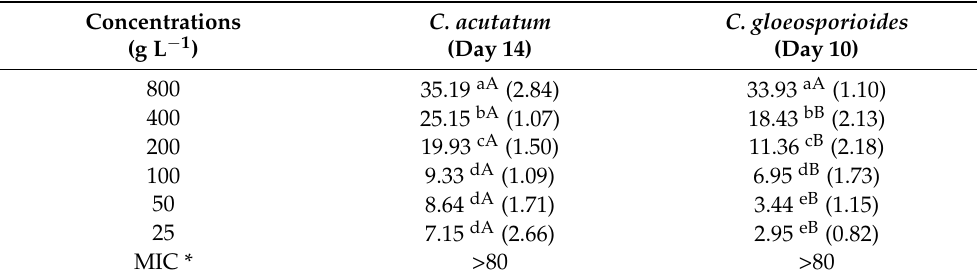
Table 2. Mycelial growth inhibition (%) of major pathogens isolated from mango exposed to various concentrations of propyl disulfide incorporated in the potato dextrose agar (PDA) medium (agar diffusion assay) at ambient temperature (26 ± 3 ◦